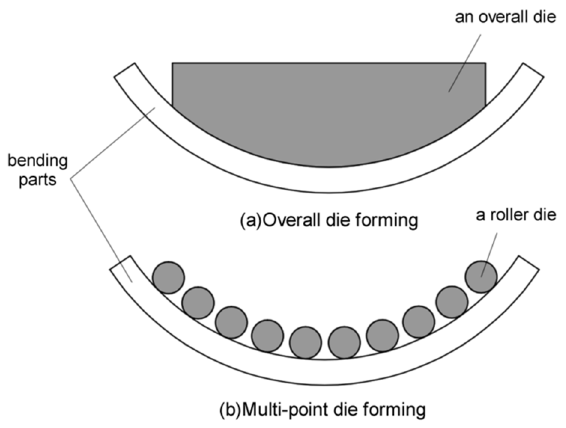
Figure 1. The schematic diagram of traditional stretch bending and FSB: ( a ) Overall die forming; ( b ) Multi ‐ point die forming.